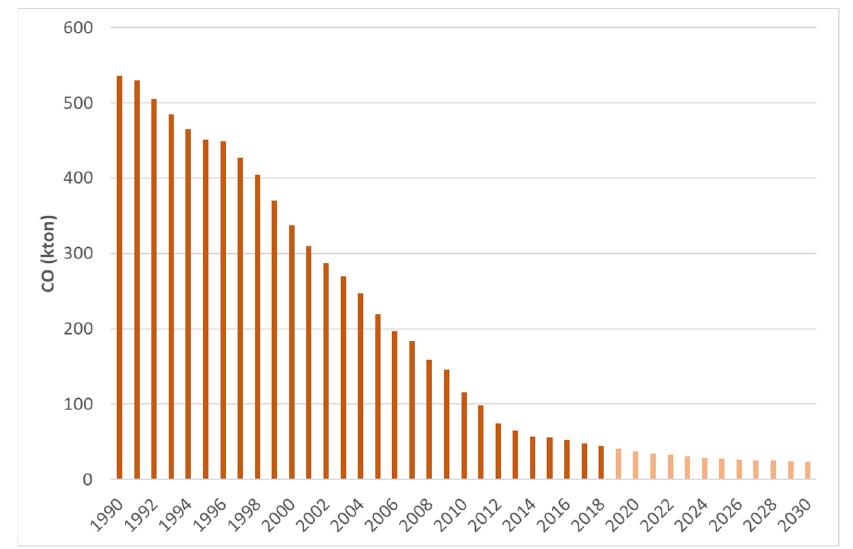
Figure 12. Total CO emissions from passenger cars in Greece for the period 1990–2030.